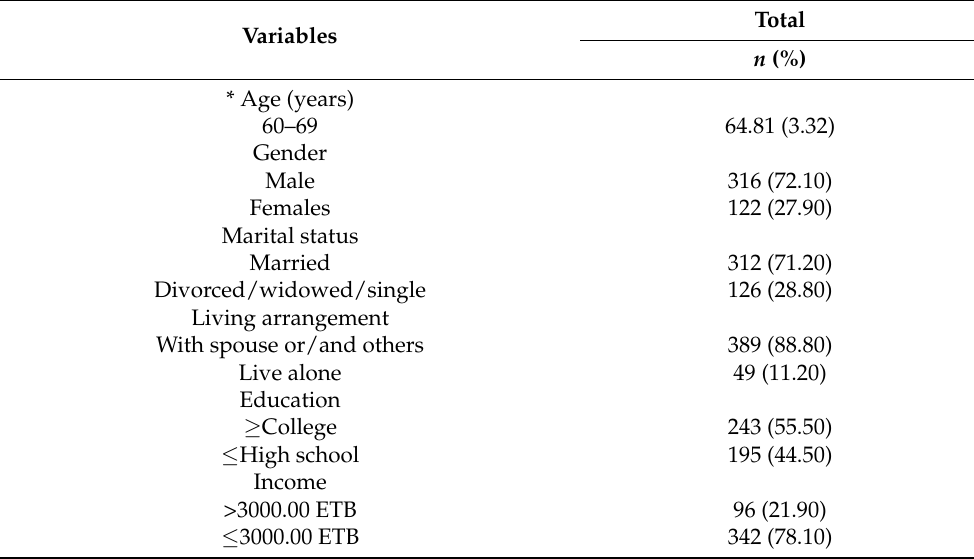
Table 1. Participants’